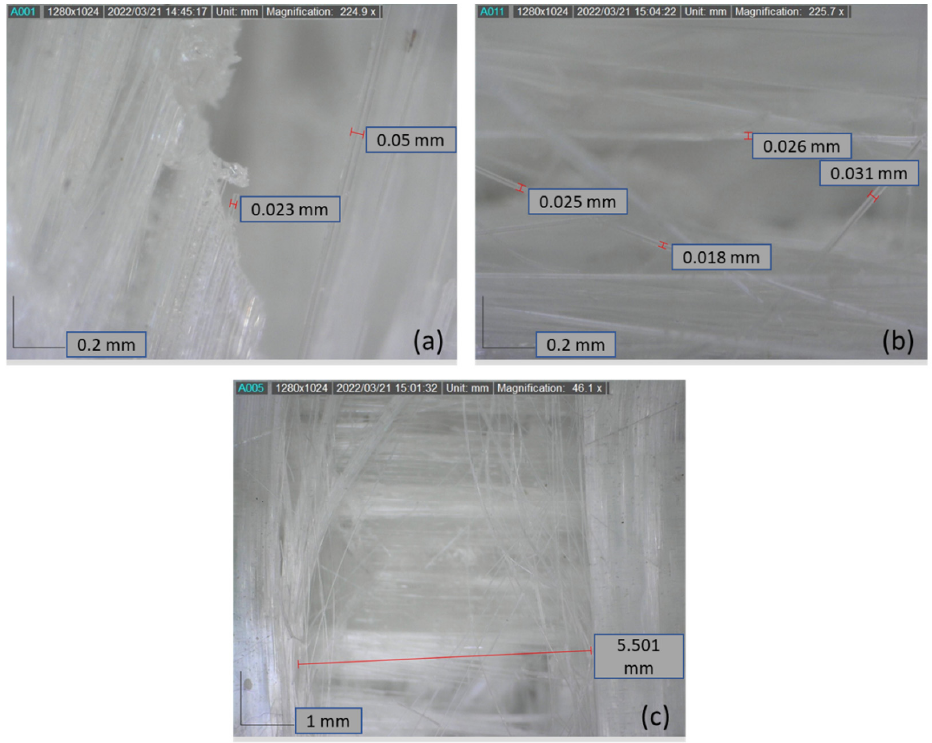
Figure 6. Micro images of failure from different specimens: ( a ) fiber breakage; ( b ) individual fibers’ random angles after failure; ( c ) 90°–0° layers gap after failures.